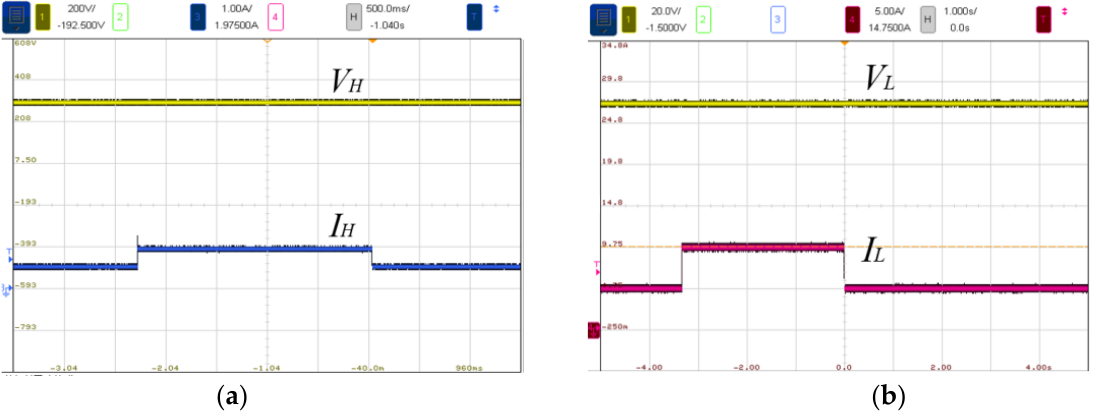
Figure 16. Measured waveforms of load variation of the proposed topology: ( a ) step-up mode, and ( b ) step-down mode.